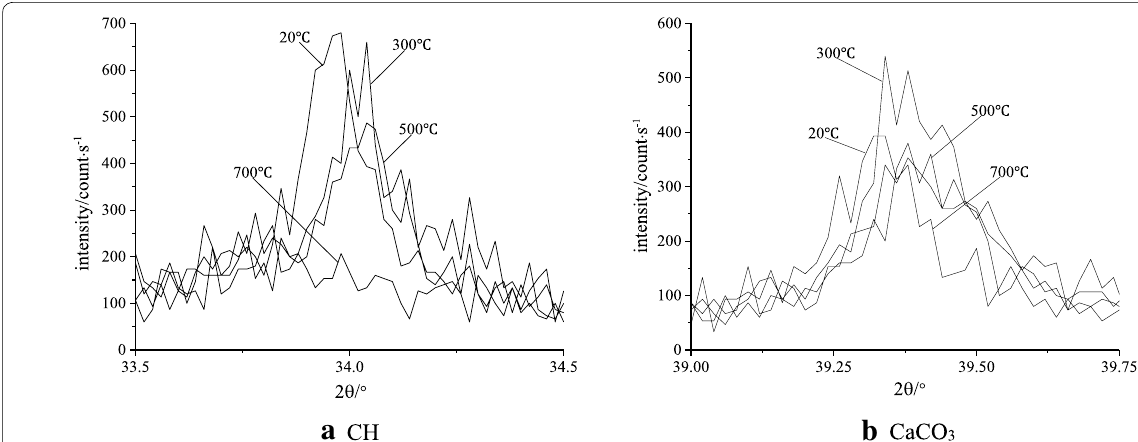
Fig. 19 X-ray analysis of specimen T5 after different temperatures.